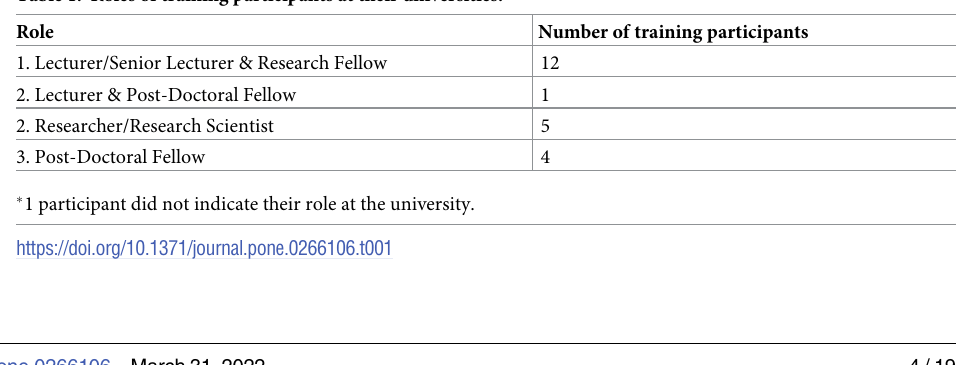
Table 1. Roles of training participants at their